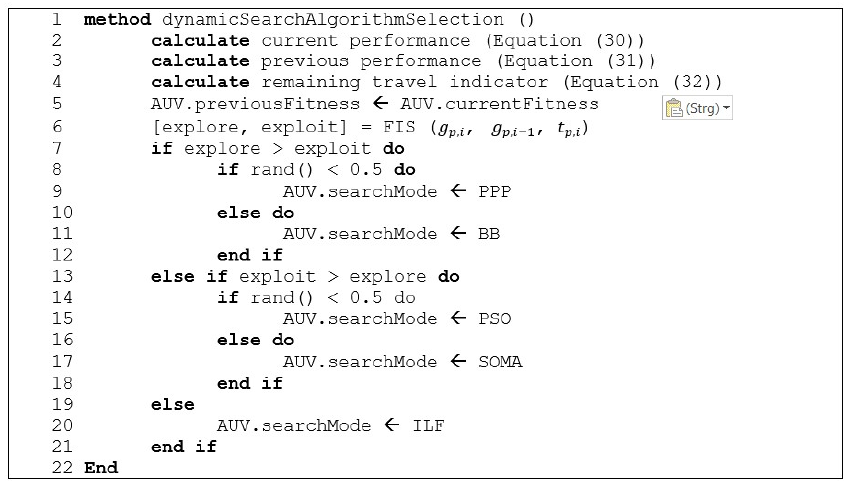
Figure 20. Pseudocode dynamic selection of search strategy utilising a fuzzy inference system (FIS).